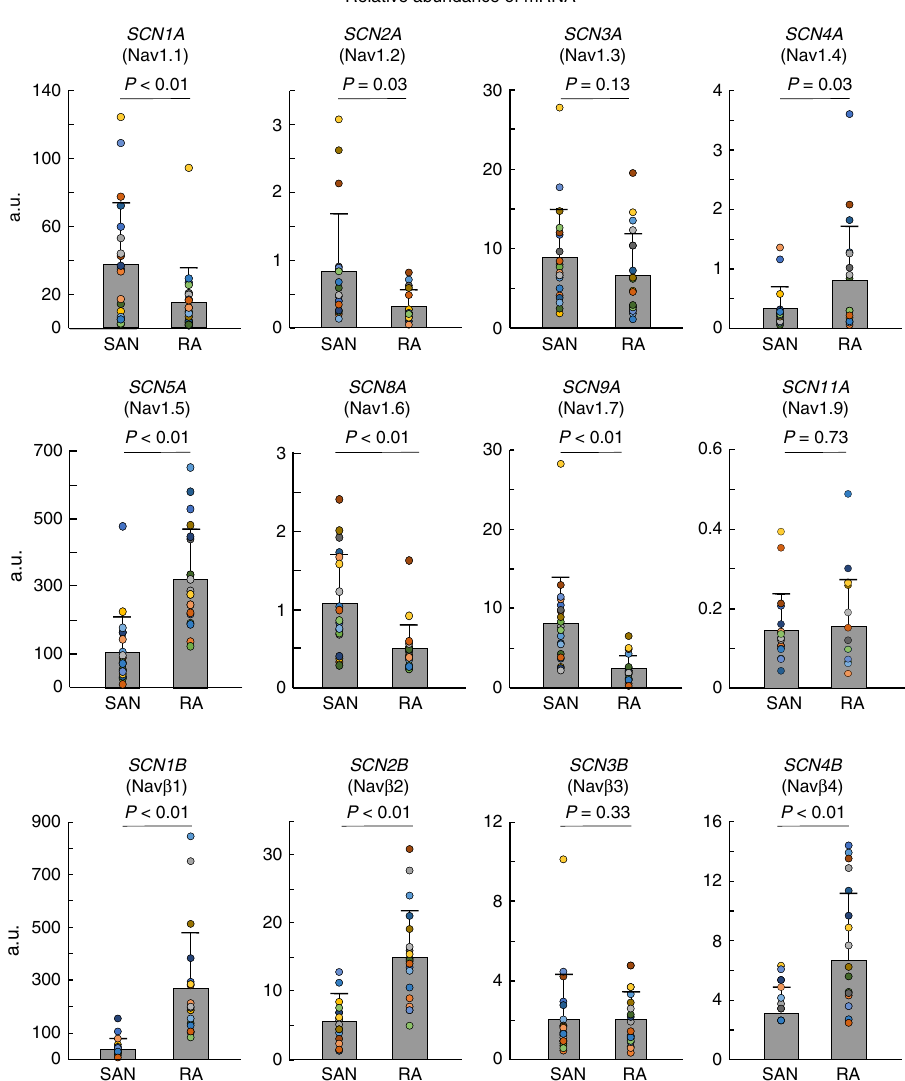
Fig. 5 Distribution of cNav and nNav subunit mRNA in the human SAN and RA. Summary data of qPCR analysis of different Nav isoform mRNA levels in the human sinoatrial node (SAN) and right atrial (RA) tissue; colored circles indicate individual data points for each human heart. All mRNA values were normalized to the ribosomal 18s gene. Nav voltage-gated sodium channels. Data were represented in mean ± SD; n = 20 for each group; normality was tested with Shapiro – Wilk test; two-sided t -test was used for parametric data and Wilcoxon ’ s test was used for non-parametric data. Source data are provided as a Source Data fi